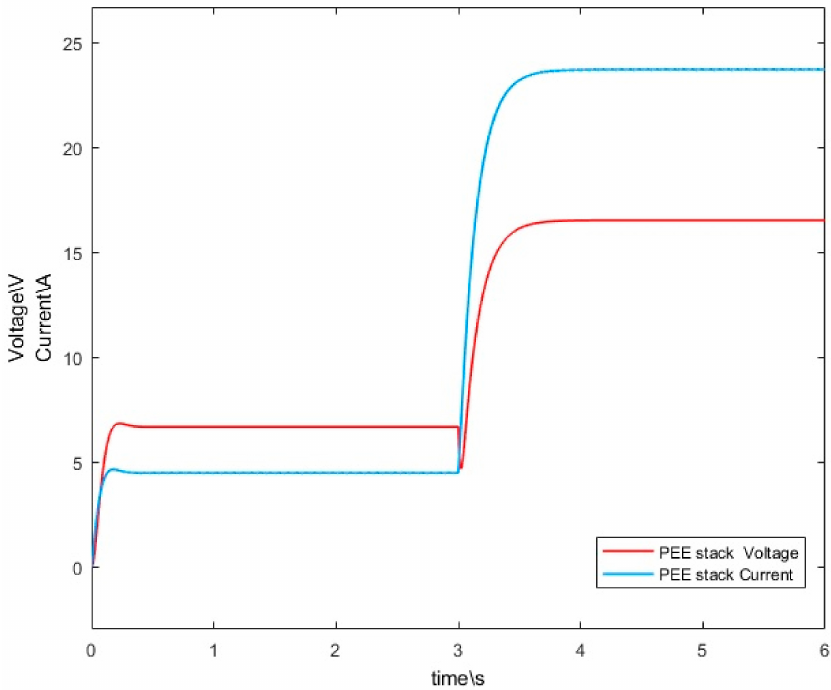
Figure 6. Time trends of PEM electrolytic stack voltage and current to a supply power variation from its minimum value to its maximum value at 3